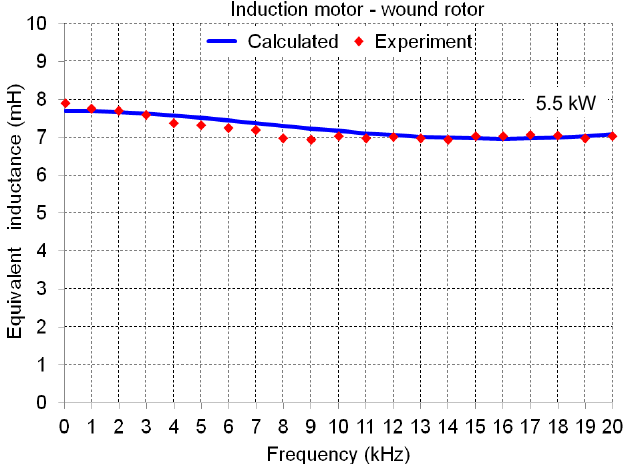
Figure 6. Model and experimental results for L eq vs supply frequency for the rotor-wound IM.